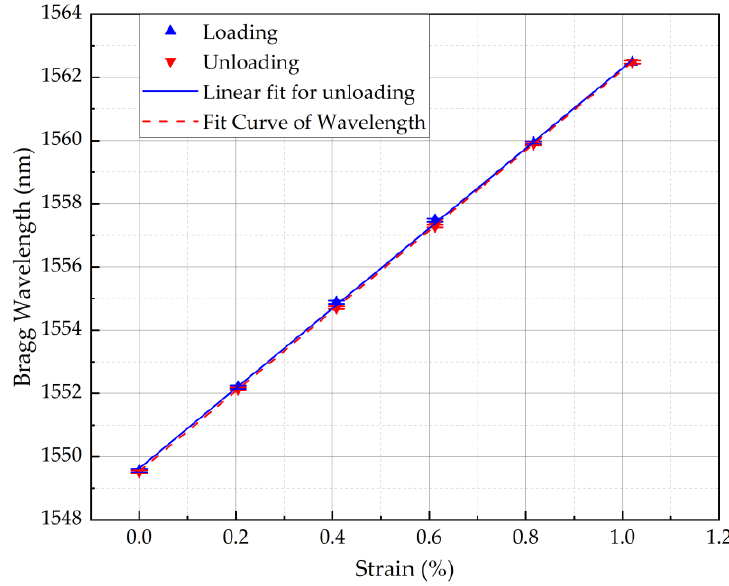
Figure 5. Strain response of POFBG sensor.